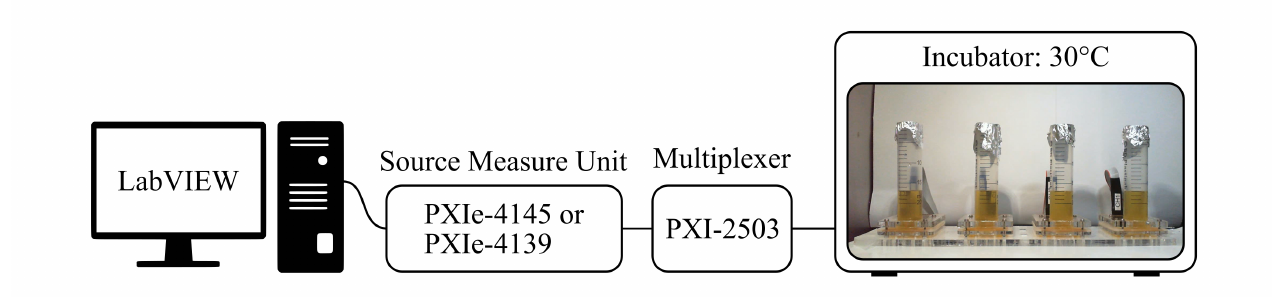
Figure 3. Schematic overview of the used measurement setup. Depending on the type of experiment, two different, yet similar, Source Measure Units were used. It should be stressed, though, that only one is required at a